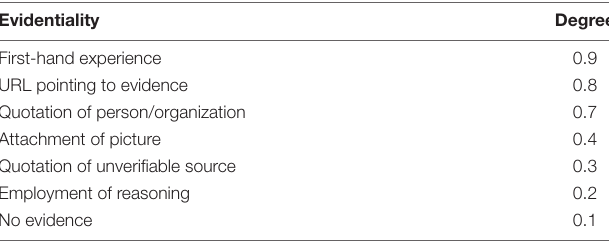
TABLE 2 | The assigned degree of evidentiality of anti-rumour (EV).